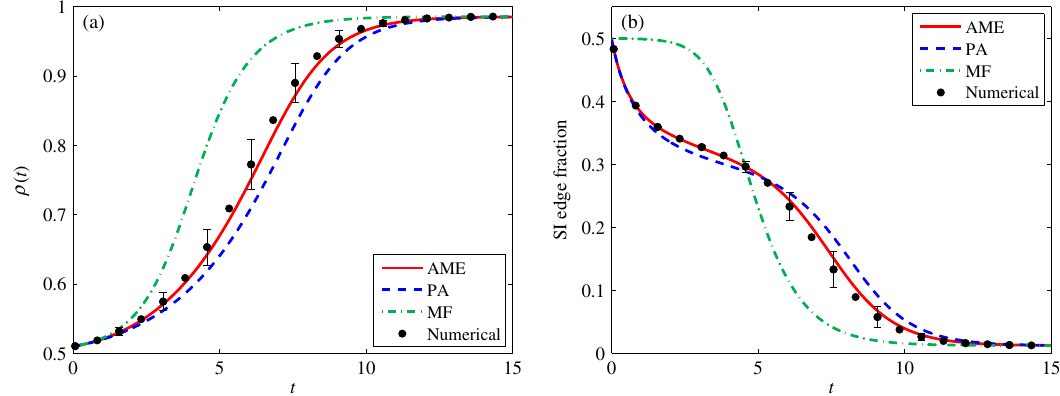
FIG. 6. Glauber dynamics for the Ising spin model dynamics on a Poisson (Erdo¨s-Re´nyi) random graph with mean degree z ¼ 7 . The interaction parameter J is set to 1, the temperature T is 2 = log ð 2 : 5 Þ (cid:6) 2 : 18 , and the initial fraction of spin-ups is